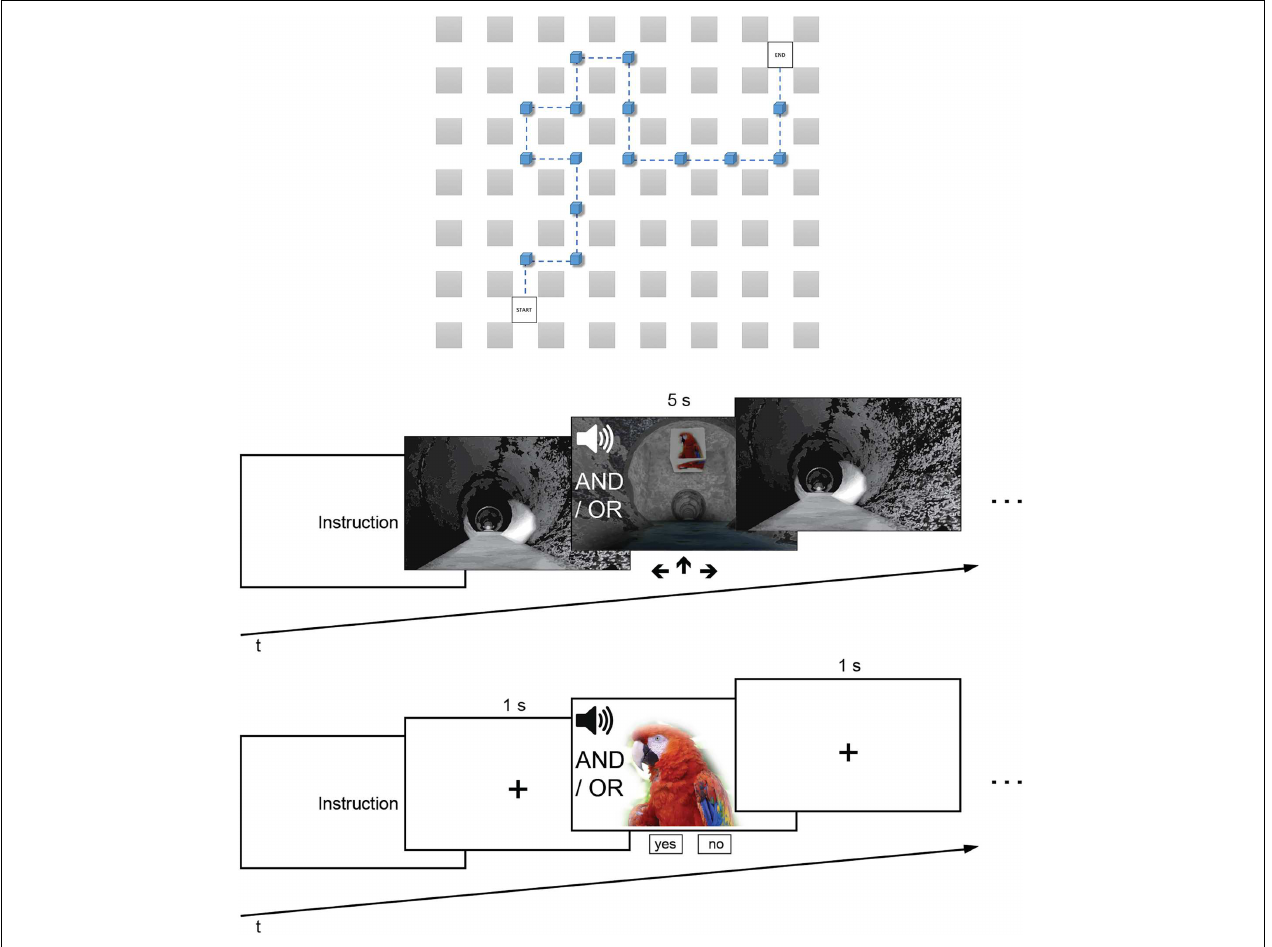
FIGURE 1 | (Top) Exemplary route of the wayfinding task from a bird’s-eye view. (Middle) Wayfinding task with acoustic and/or visual landmarks. (Bottom) Recognition task in which participants indicated whether they had seen and/or heard the landmark or